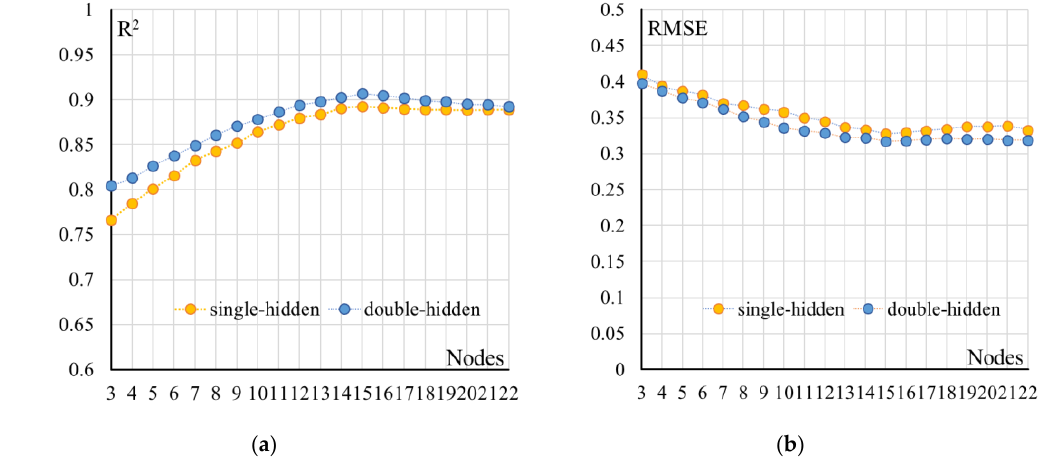
( b ) ( b ) ( b ) Figure 3. Comparison chart of the accuracy for different structures. ( a ) Comparison chart of R 2 ( b ) Figure 3. Comparison chart of the accuracy for different structures. ( a ) Comparison chart of R 2 between single-hidden and double-hidden layers with nodes (from 3 to 22); ( b ) Comparison chart of Figure 3. Comparison chart of the accuracy for different structures. ( a ) Comparison chart of R 2 Figure3. Comparisonchartoftheaccuracyfordi ff erentstructures. ( a )ComparisonchartofR 2 between between single-hidden and double-hidden layers with nodes (from 3 to 22); ( b ) Comparison chart of Figure 3. Comparison chart of the accuracy for different structures. ( a ) Comparison chart of R 2 Figure3. Comparisonchartoftheaccuracyfordi ff erentstructures. ( a )ComparisonchartofR 2 between RMSE between single-hidden and double-hidden layers with nodes (from 3 to 22). between single-hidden and double-hidden layers with nodes (from 3 to 22); ( b ) Comparison chart of single-hiddenanddouble-hiddenlayerswithnodes(from3to22);( b )ComparisonchartofRMSE RMSE between single-hidden and double-hidden layers with nodes (from 3 to 22). between single-hidden and double-hidden layers with nodes (from 3 to 22); ( b ) Comparison chart of single-hiddenanddouble-hiddenlayerswithnodes(from3to22);( b )ComparisonchartofRMSE RMSE between single-hidden and double-hidden layers with nodes (from 3 to 22). betweensingle-hiddenanddouble-hiddenlayerswithnodes(from3to22). RMSE between single-hidden and double-hidden layers with nodes (from 3 to 22). betweensingle-hiddenanddouble-hiddenlayerswithnodes(from3to22).